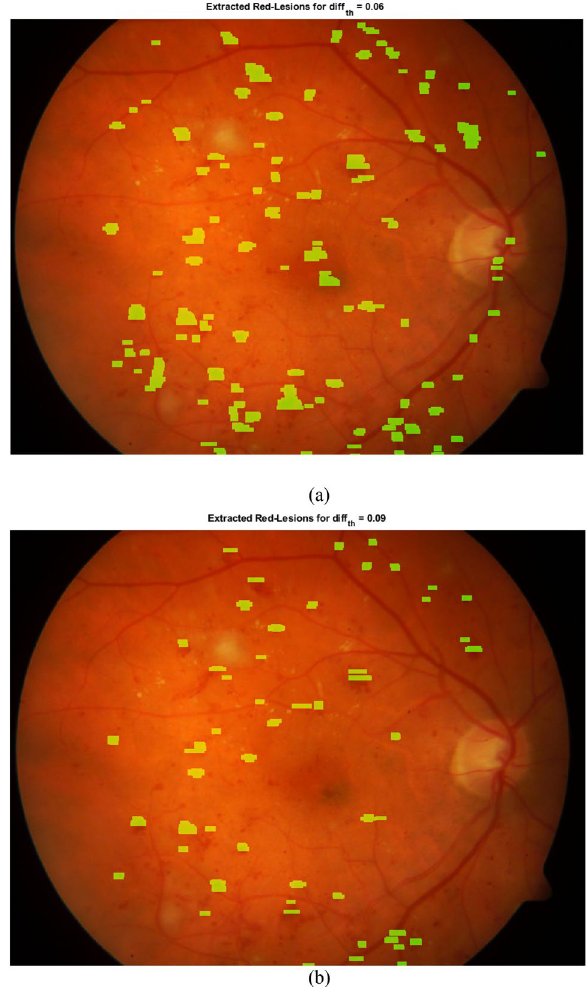
Figure 6. The effect of two values of diff_th on the capability of red-lesion